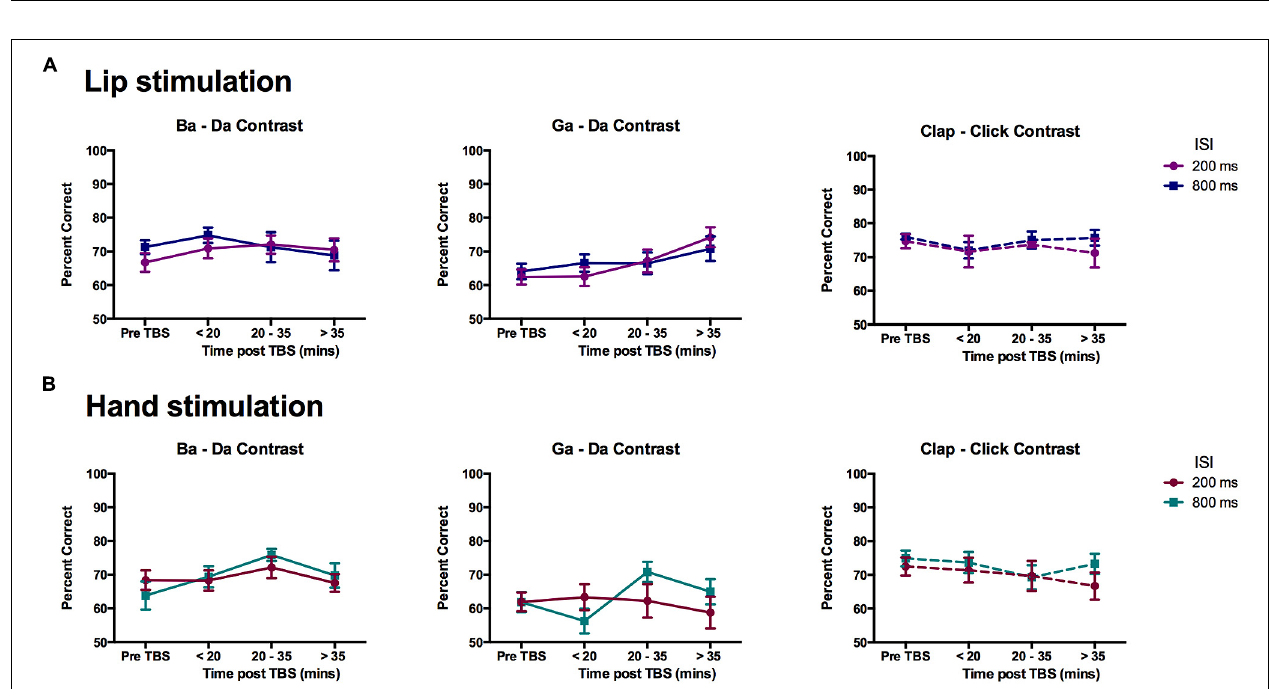
the experiment with the two ISI plotted as separate lines. Error bars represent the SE of the mean.The only significant reduction in performance was seen for the data obtained between 20 and 35 min post-cTBS to the lip representation for the lip-articulated “ba”–“da” contrast.